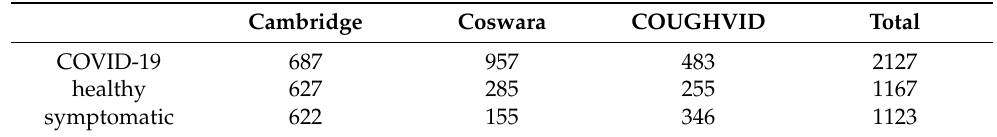
Table 3. Number of cough segments